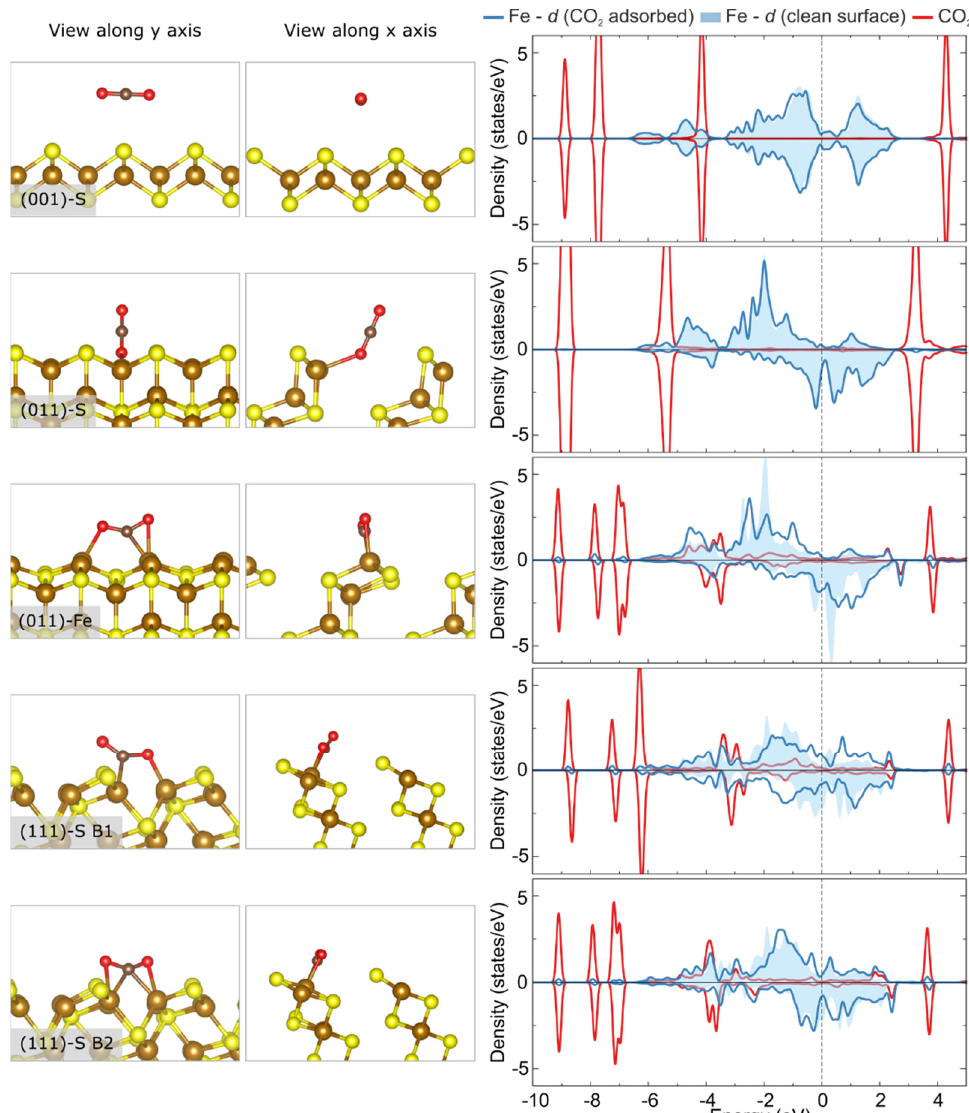
Figure 4. Optimised structures of the CO 2 molecule adsorbed on the pristine surfaces of FeS (left) together with the accompanying electronic densities of the state (right).